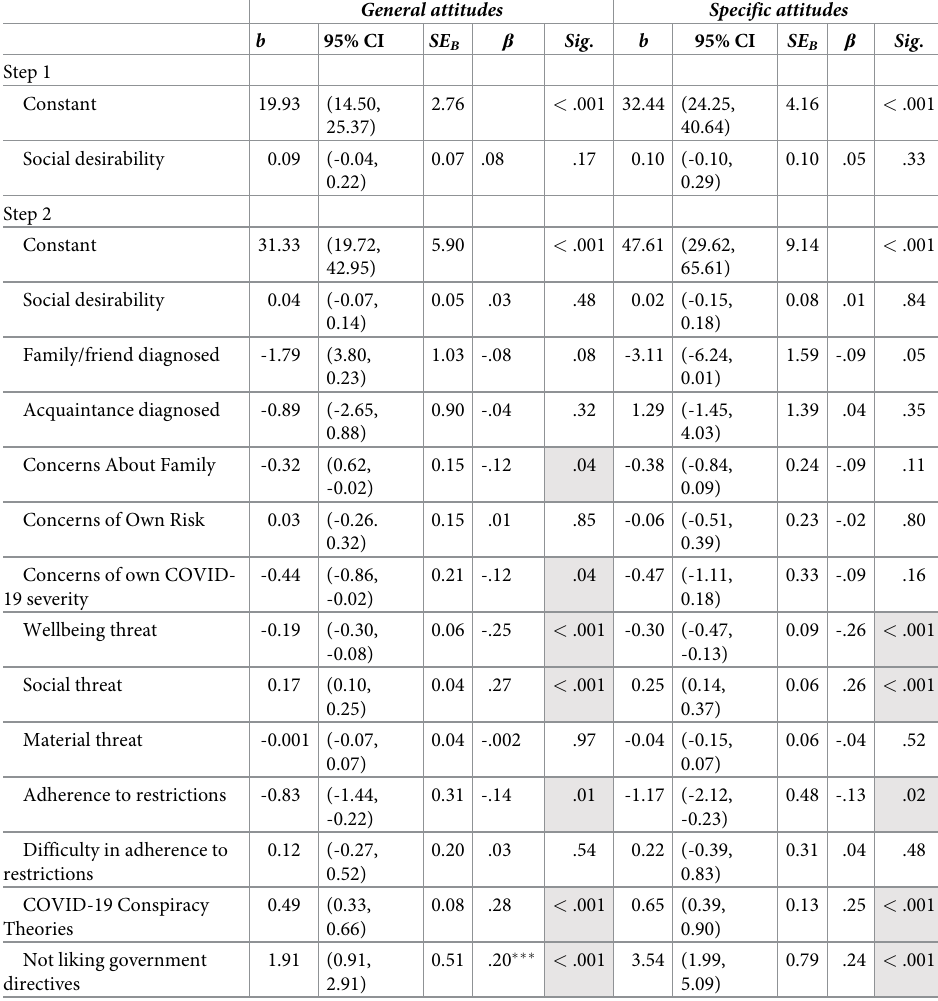
Table 12. Multiple regression for predicting attitudes to easing COVID-19 restrictions for